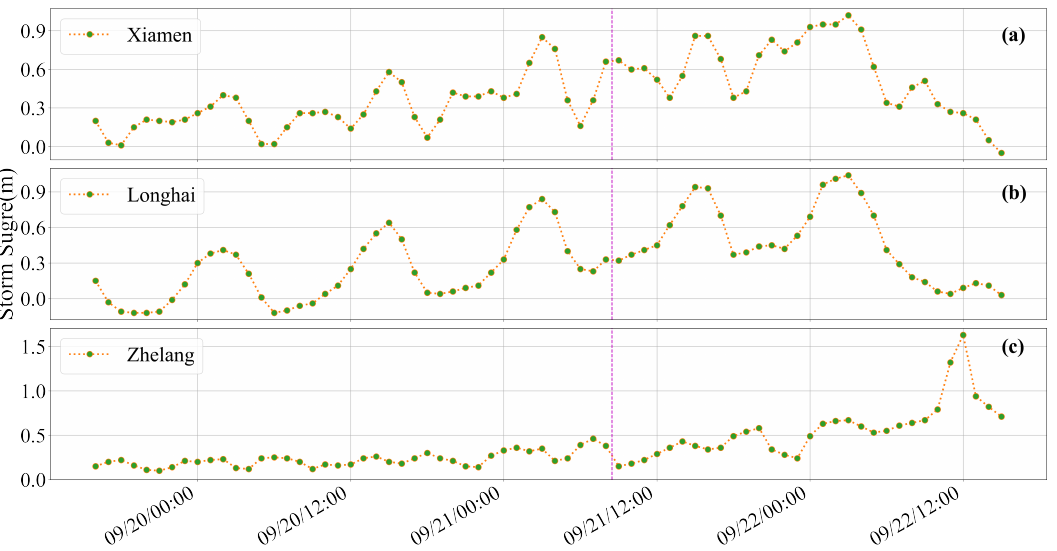
Figure 3. De-tided SLAs induced by 1319Usagi at ( a ) Xiamen, ( b ) Longhai, and ( c ) Zhelang tide gauge stations. The magenta dashed lines indicate the passing time of the Jason-2 satellite (08:29 UTC on 21 September 2013). The landing time of 1319Uasgi was 11:40 on 22 September. Fortunately, the Jason-2 altimeter satellite passed over the South China Sea near Xiamen Fujian at 08:29 UTC on 21 September 2013, providing valuable information for the investigation of the storm surge. As the coastal data of cycle-773 were invalid in the CTOH L3 TPJ1J2 product, it was replaced by cycle-772. The SLAs of the Jason-2 altimeter track-88 from cycle-772, cycle-774, and cycle-775 are shown in Figure 4a. The variations in the magnitude of sea surface height anomalies before (cycle-772, 12:36 UTC on 1 September 2013) and after (cycle-775, 06:31 UTC on 1 October 2013) the storm were distinct, with a shift from the increasing trend of SLA recorded by Jason-2 during the storm (cycle-774). Additionally, the SLAs of cycle-774 significantly increased from the shelf break at 22°N toward the coast. Conversely, the SLAs of cycle-772 and cycle-775 were nearly zero near the coast and did not show a clear storm surge signal. The magenta dashed line in Figure 3a,b represents the passing time of the Jason-2 satellite. The closest measurement of SLA to the coastline (about 3 km away) by track-88 from cycle-774 of the Jason-2 altimeter was 0.55 m, while the measurements simultaneously made by the Xiamen, Longhai, and Zhelang tide gauge stations were 0.66, 0.33, and 0.38 m, respectively. We took the average of the observed values at the three tide stations, which was approximately 0.46 m; the observed value of the altimeter was in close agreement with this